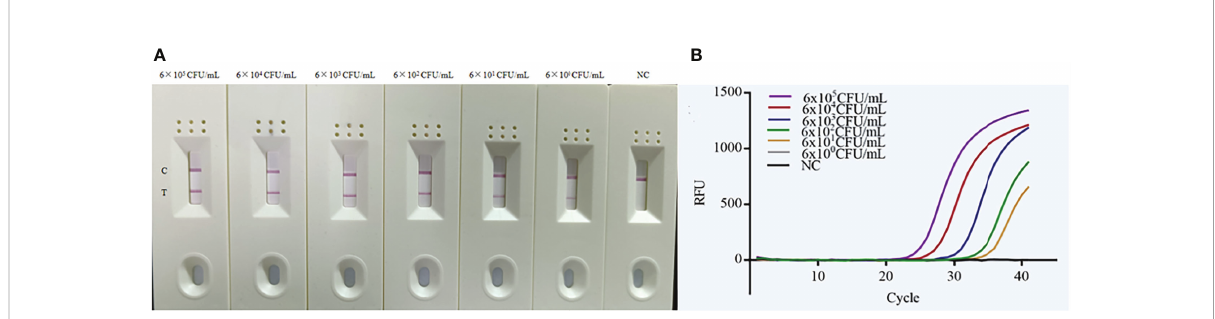
FIGURE 3 Sensitivity of the MIRA-LFD assay and the real-time PCR assay. (A) Serially diluted gDNA of targeted bacteria (6×10 5 CFU/mL, 6×10 4 CFU/mL, 6×10 3 CFU/mL, 6×10 2 CFU/mL, 6×10 1 CFU/mL and 6×10 0 CFU/mL per reaction) was tested by MIRA-LFD at 40°C for 10 min. This experiment was repeated four times for low-concentrated samples (6 CFU/mL). NC, negative control; C, control line; T, test line. (B) The quantity of genomic DNA of A baumannii was tested by real-time PCR at 95°C for 5 min, followed by 40 cycles of 95°C for 10 seconds and 60°C for 30 seconds.